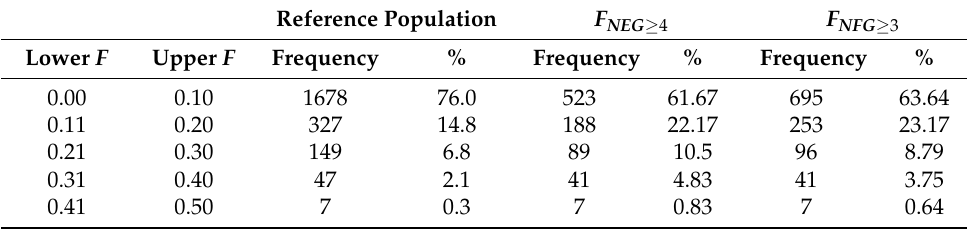
Figure 4. Mean coefficient of inbreeding ( F ) by year of birth for different levels of PCI. The distribution of the coefficient of inbreeding ( F ) in the reference population is presented in Table 6. Three quarters of the animals (~75%) had F below 10%. F between 11% and 20% was found in 15% of the animals, and an extremely high level of inbreeding ( F > 20%) was determined in 10% of the population. When constraints were imposed on NEG ≥ 4 and NFG ≥ 3, the distribution of F shifted towards higher values of F , with marginal differences between F NEG ≥ 4 and F NFG ≥ 3 . The average coefficients of inbreeding per generation ( F NEG ≥ 4 and F NFG ≥ 3 ) are presented in the last column of Tables 7 and 8. The estimated inbreeding rates per generation ∆ F NEG ≥ 4 and ∆ F NFG ≥ 3 were − 0.0013 ± 0.0005 ( p > 0.05) and 0.003 ± 0.0006 ( p < 0.05), respectively. Table 6. Distribution of the estimated coefficient of inbreeding ( F ) in the reference population (2010–2018).